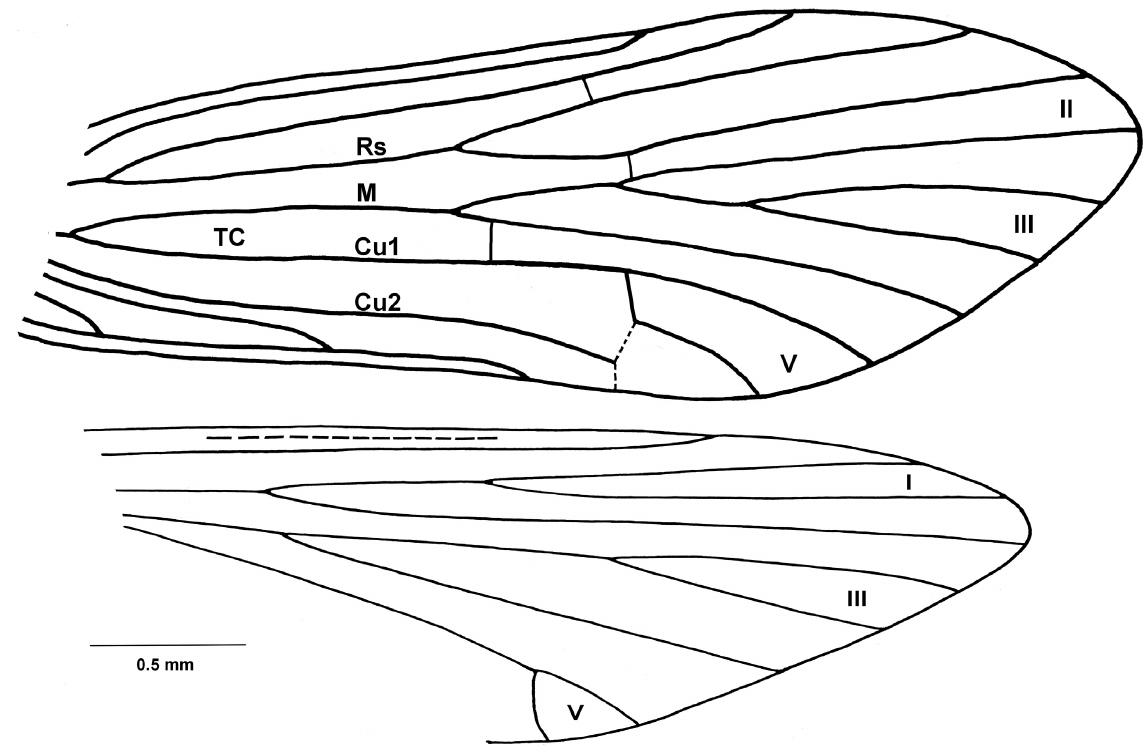
Fig. 1. Cretapsyche Wichard, Neumann, Müller & Wang, 2018, wing venation in forewing with forks II, III, and V present, discoidal and thyridial cells open or closed, nygmata absent, in hindwing with forks I, III, and V usually